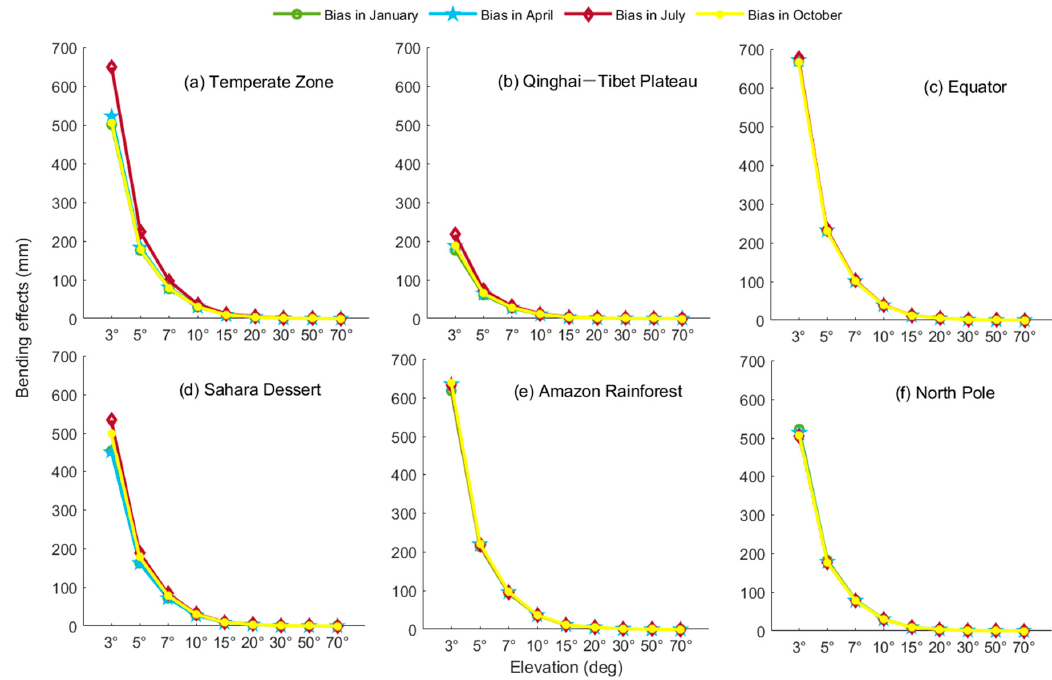
Figure 8. The bending effects for the six regions at different elevations (70°, 50°, 30°, 20°, 15°, 10°, 7°, 5°, and 3°): ( a ) Temperate Zone ( b ) Qinghai—Tibet Plateau ( c ) Equator ( d ) Sahara Dessert ( e ) Amazon Rainforest ( f ) North Pole.